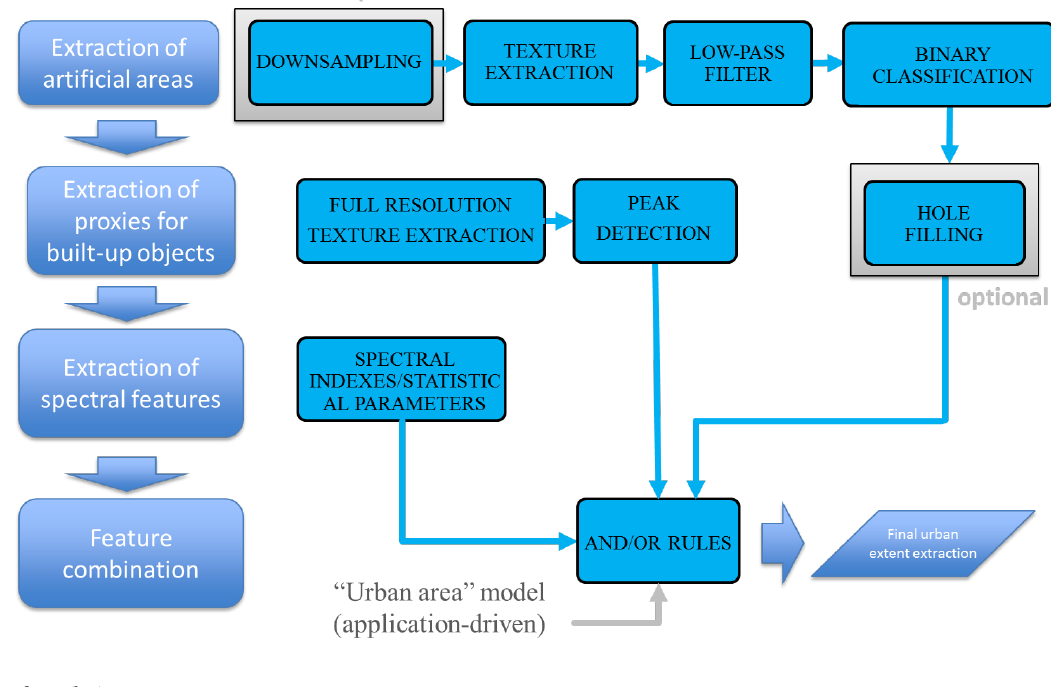
Figure 1. Graphical representation of the overall processing framework proposed in this paper. The framework includes spectral and multi-scale spatial features, independently extracted from the input data and eventually combined according to logical rules (AND, OR) to match the urban area definition most suitable to the final application